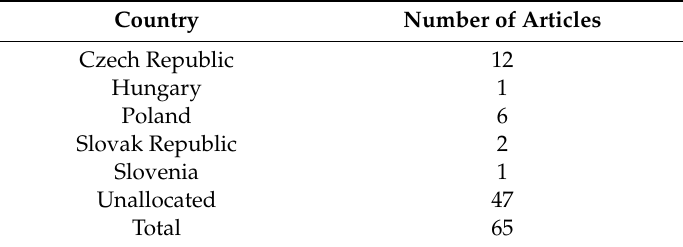
Table 3. Number of papers by